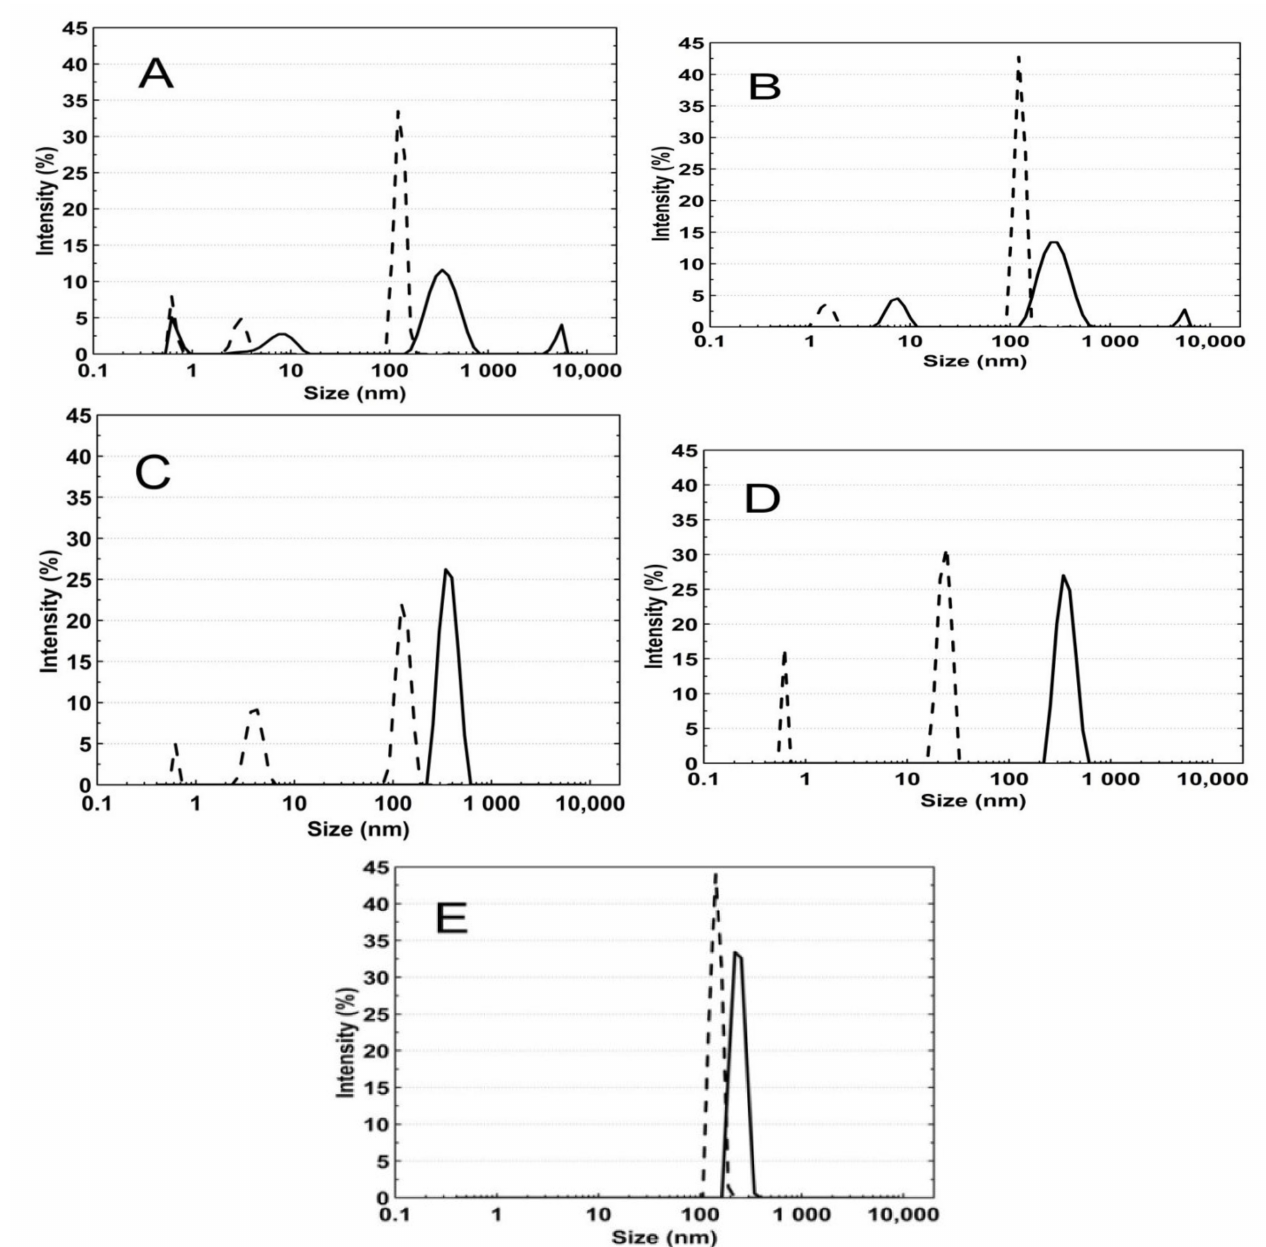
Figure 8. (A – E ) Intensity size distribution curves for the PS1 ( A ), PS2 ( B ), PS3 ( C ), PS4 ( D ), and PS5 ( E ) dispersions at 18 ◦ C—solid line and 45 ◦ C—dash line, determined by dynamic light